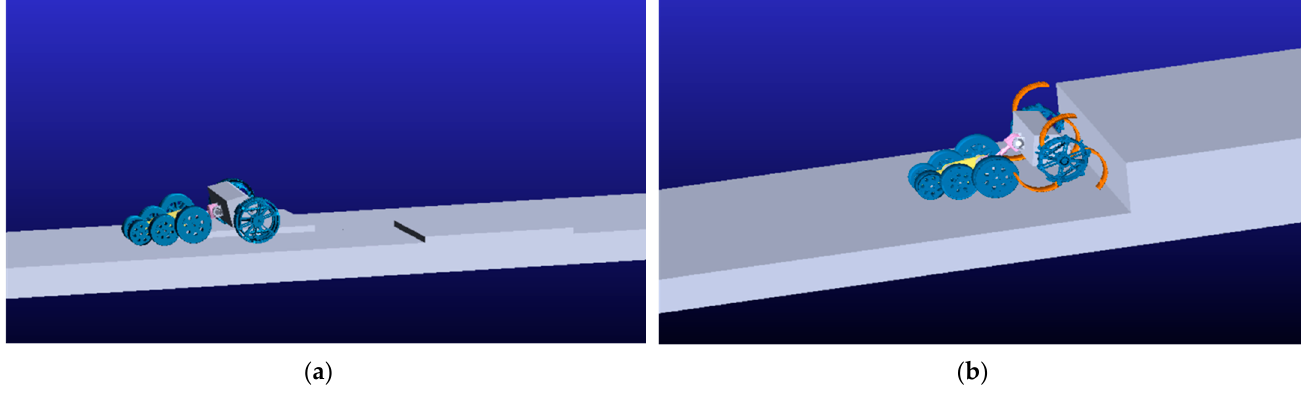
Figure 20. ADAMS simulation diagram. ( a ) Simulation drawing of crossing one side step; ( b ) simulation drawing of crossing vertical terrain.